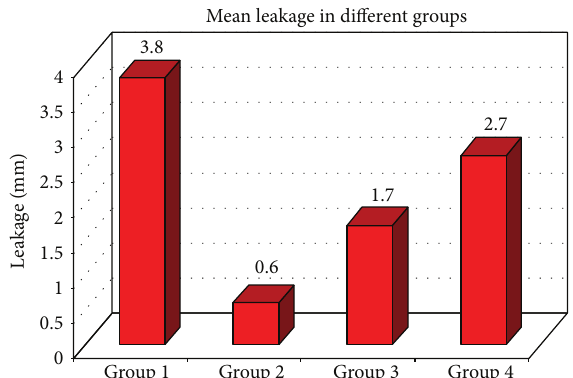
Figure 3: Comparison of mean of microleakage scores in different